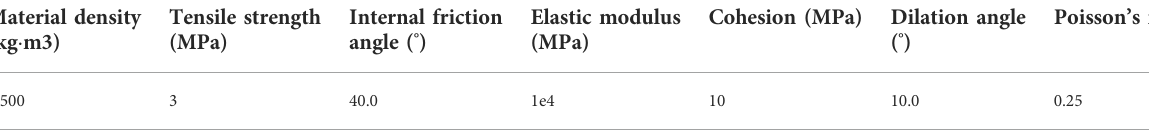
TABLE 2 Calculated mechanical parameters of the rock mass.